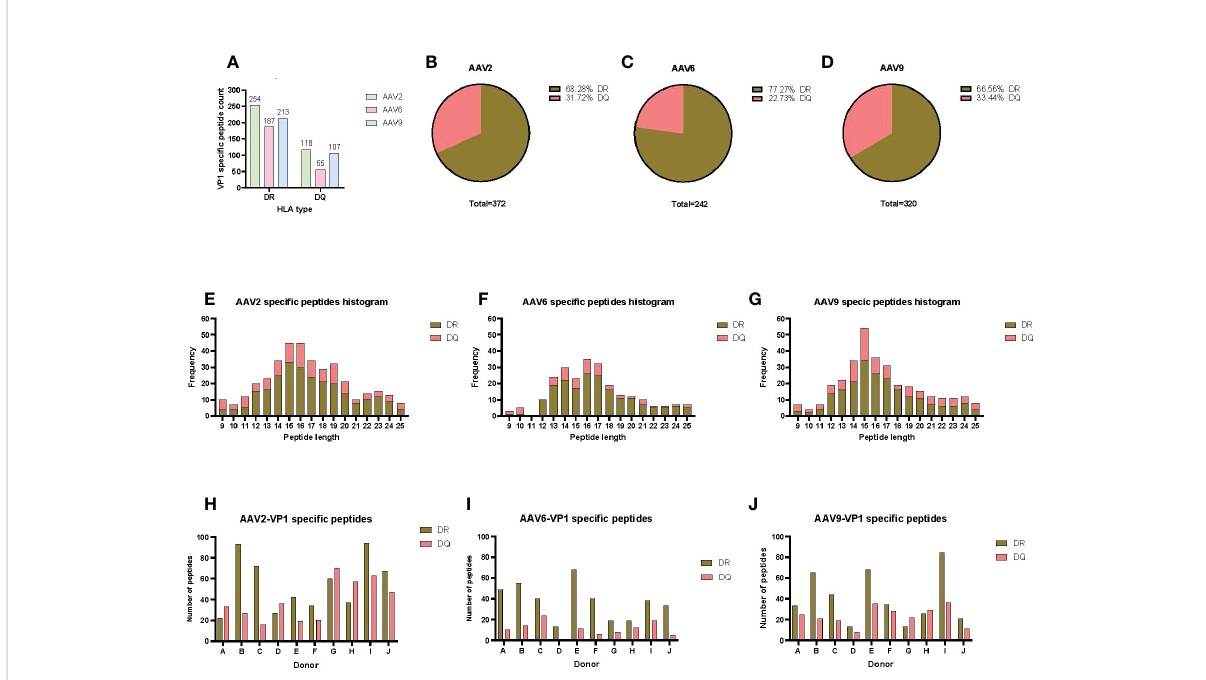
FIGURE 1 AAV serotypes are prominently presented by both HLA DR and DQ receptors. (A) Bar graph of the total AAV VP1 unique capsid peptide count per serotype and HLA type. (B – D) Pie charts representing the proportion of DR vs DQ peptides identi fi ed for AAV2 (B) , AAV6 (C) and AAV9 (D) . (E – G) Histograms representing the distribution of the identi fi ed HLA class-II peptide lengths from the VP1 capsid of AAV2 (E) , AAV6 (F) and AAV9 (G) . (H – J) Bar graphs showing total number of VP1 capsid protein peptides identi fi ed per donor for AAV2 (H) , AAV6 (I) and AAV9 (J) . The donor identi fi er is listed on the X-axis.